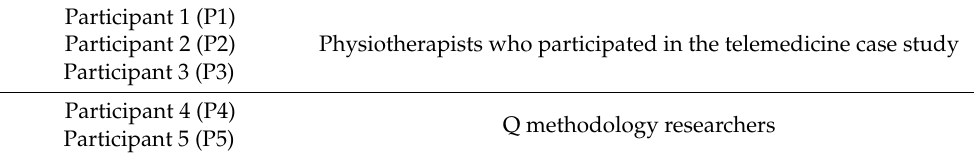
Table 1. Participants’